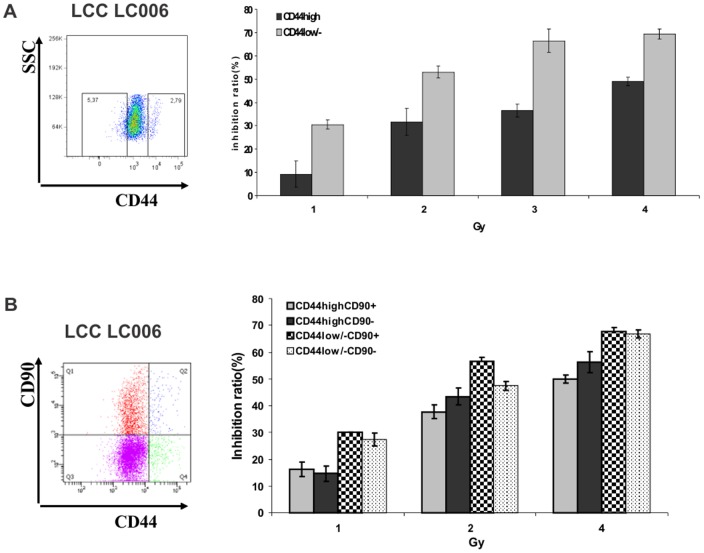
Relative irradiation resistance of different sorted cell populations from the cell line LC006. A.The relative resistance to irradiation of the FACS sorted CD44high and CD44low/− cells derived from the LCC cell line LC006 was compared in an X-ray radiation resistance assay. The inhibition ratios were compared among the different cell populations after irradiating the monolayer cultures at 1, 2, 3 and 4Gy. The CD44high cells displayed the higher resistance to X-ray radiation at each dose tested. P<0.01. B. relative resistance to irradiation of the four different FACS sorted cell populations derived from the LCC cell line LC006 was compared in an X-ray radiation resistance assay. Four populations: CD44highCD90+, CD44highCD90−, CD44low/−CD90+ and CD44low/−CD90− cells were sorted into 96-well plates at 500 cells per well in 10 replicates. The inhibition ratios were compared among the four sub-populations after irradiation of the monolayer layer of the cultures at 1, 2 and 4Gy. The CD44highCD90+ cells displayed the highest resistance to irradiation at 2 and 4G. P<0.01.